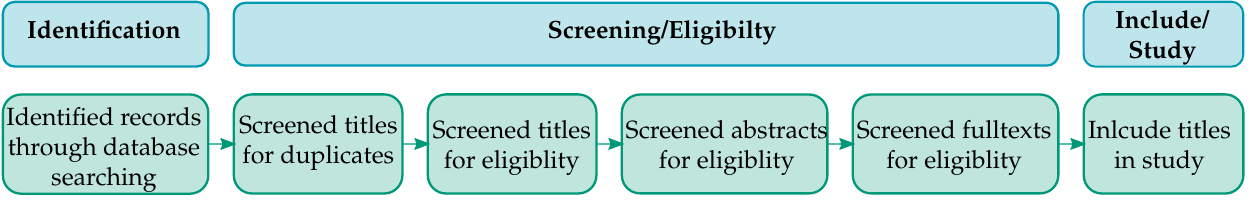
Figure 1. Workflow for selecting studies for the systematic literature review based on the PRISMA workflow [4]. The table produced in the final step of the identification process with the keyword search has been screened for duplicates. This included identical titles, titles with different capitalization of the words and abbreviated titles with identical listed authors and